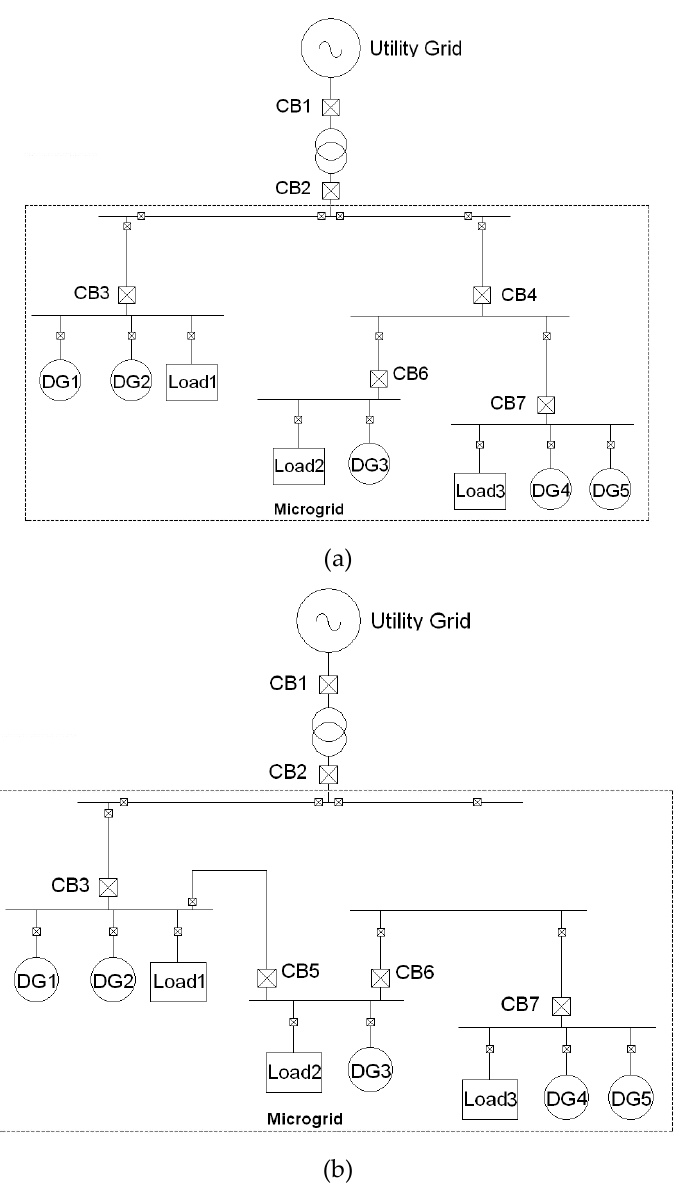
Figure 3. ( a ) The network structure when CB5 is open and CB4 is closed. ( b ) The network structure Figure 3. (a) The network structure when CB5 is open and CB4 is closed. (b) The network structure when CB5 closes and CB4 when CB5 closes and CB4 opens.